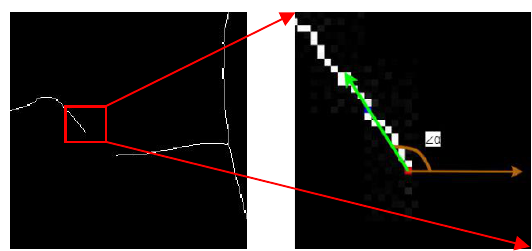
Figure 5. Tangential angle definition of